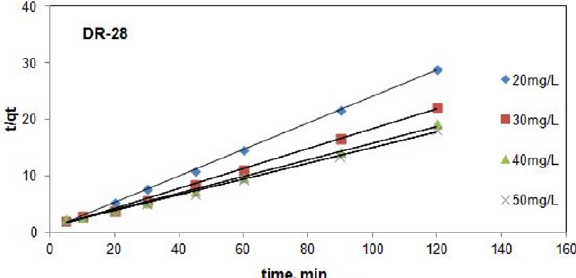
Fig. 13 Pseudo second order model for the adsorption of DR-28 onto KZF